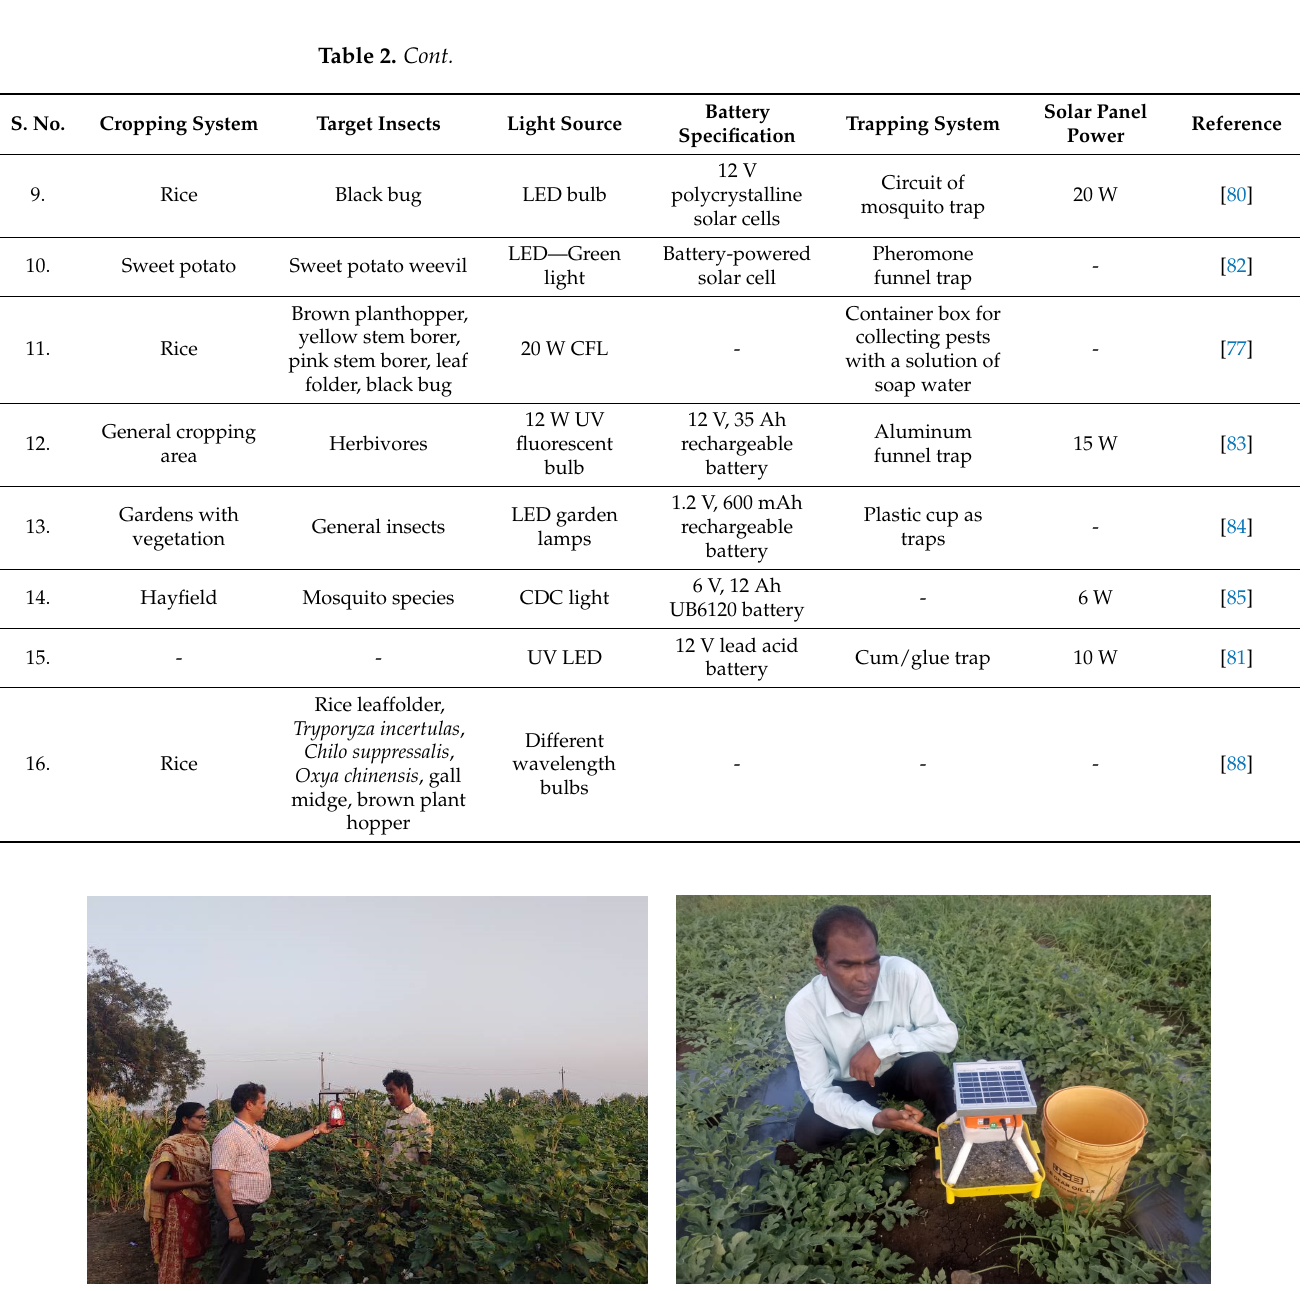
Figure 3. Solar insect light trap.